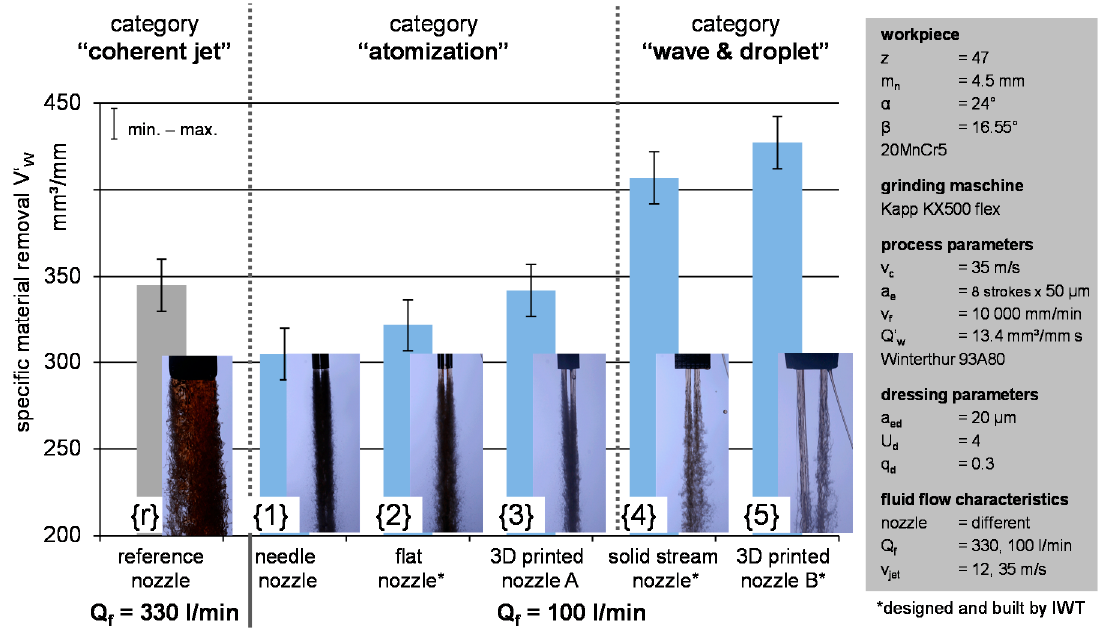
Figure 10. Grinding tests—Influence of the jet breakup.